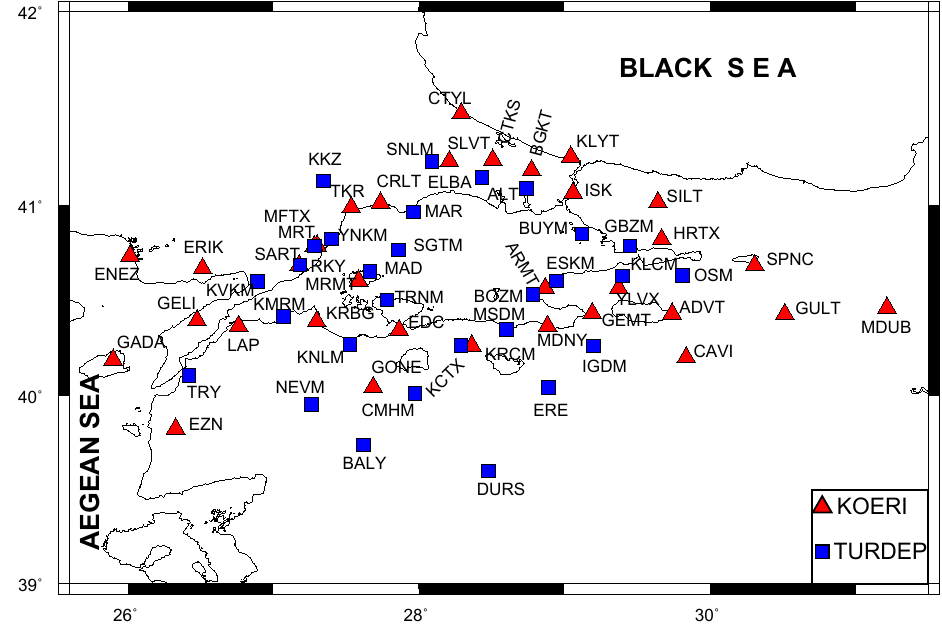
Fig. 2. Seismic stations used in the study. KOERI and TURDEP stations are depicted by red triangles and blue squares